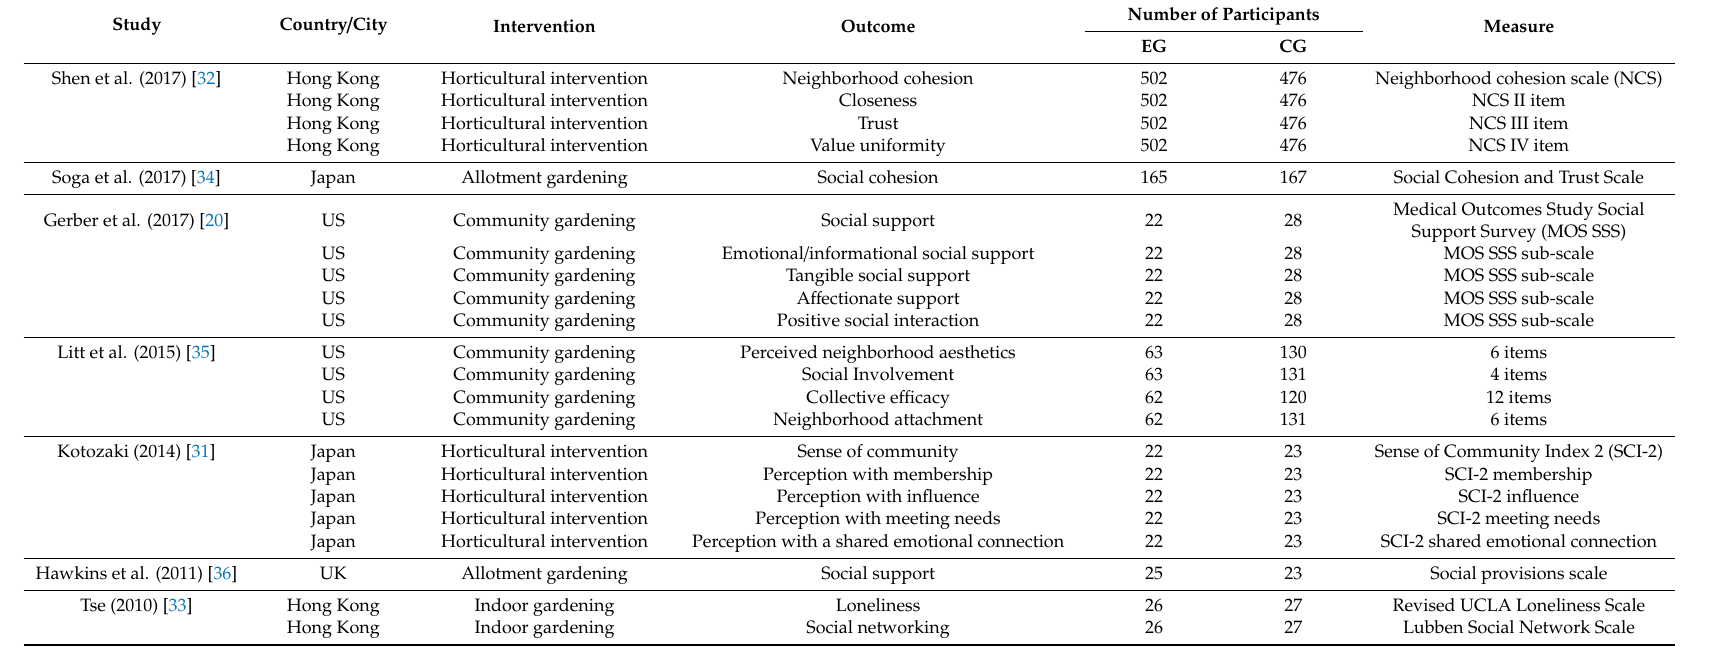
Table 1. Characteristics of experimental comparisons included in the meta-analysis. EG = Experimental Group; CG = Control Group. In the allotment gardening intervention, each plot-holders garden deals individually with an allotment plot but in close proximity to one another. In the indoor gardening intervention, all gardening activities were carried out in a room of the nursing